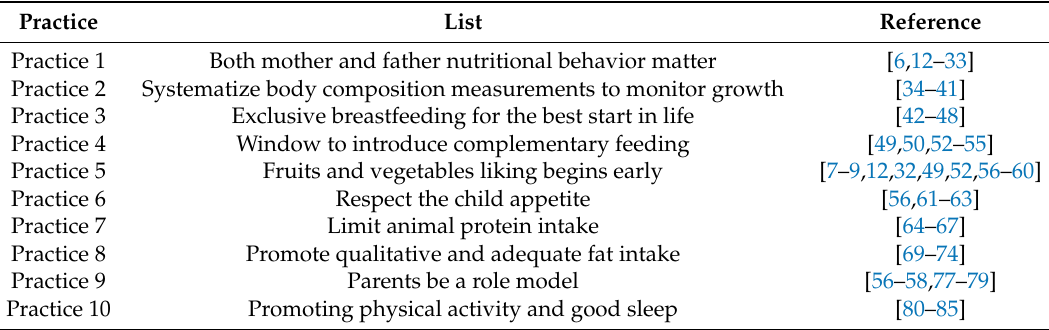
Table 1. Summary of ten good practices to help prevent/combat pediatric obesity.